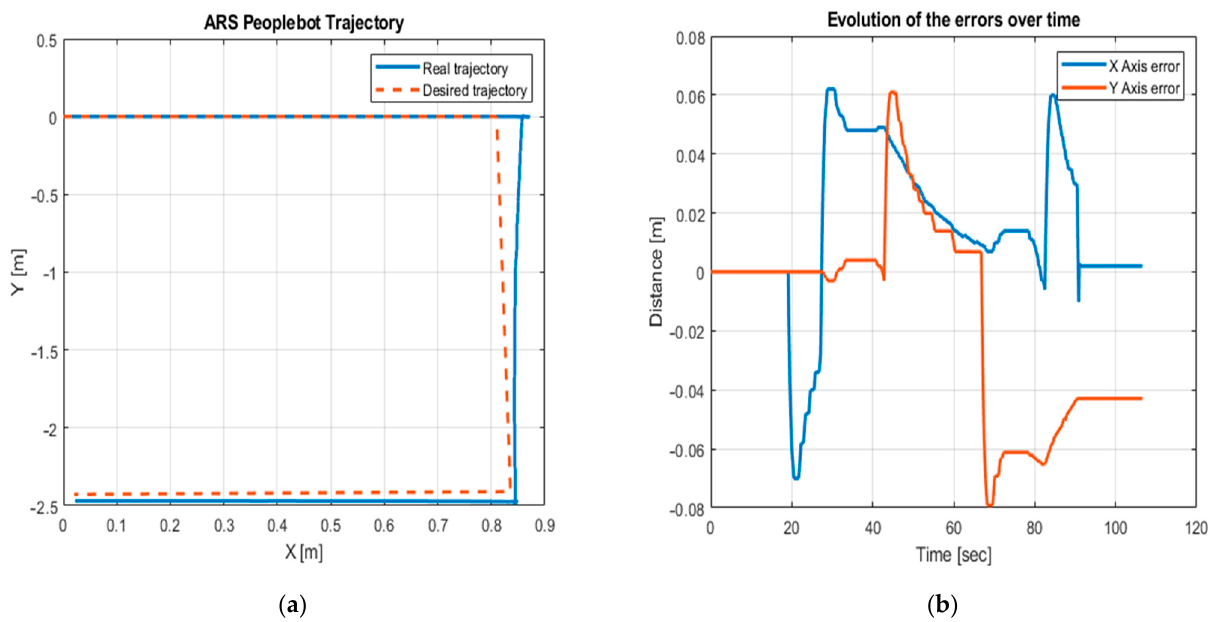
Figure 19. ( a ) Real and desired trajectories of the ARS PeopleBot and ( b ) evolution of the errors in time.